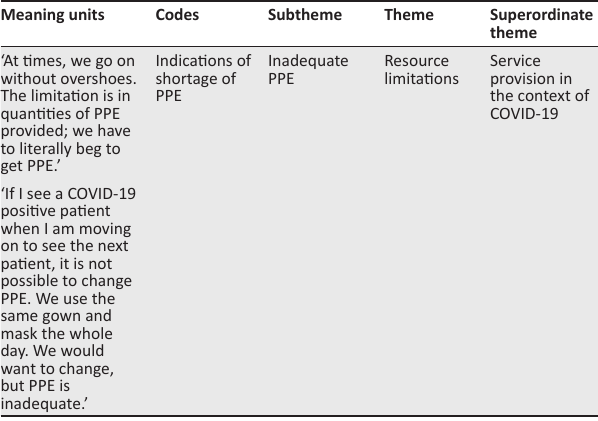
TABLE 1: Demographic data of the study participants. Participant code